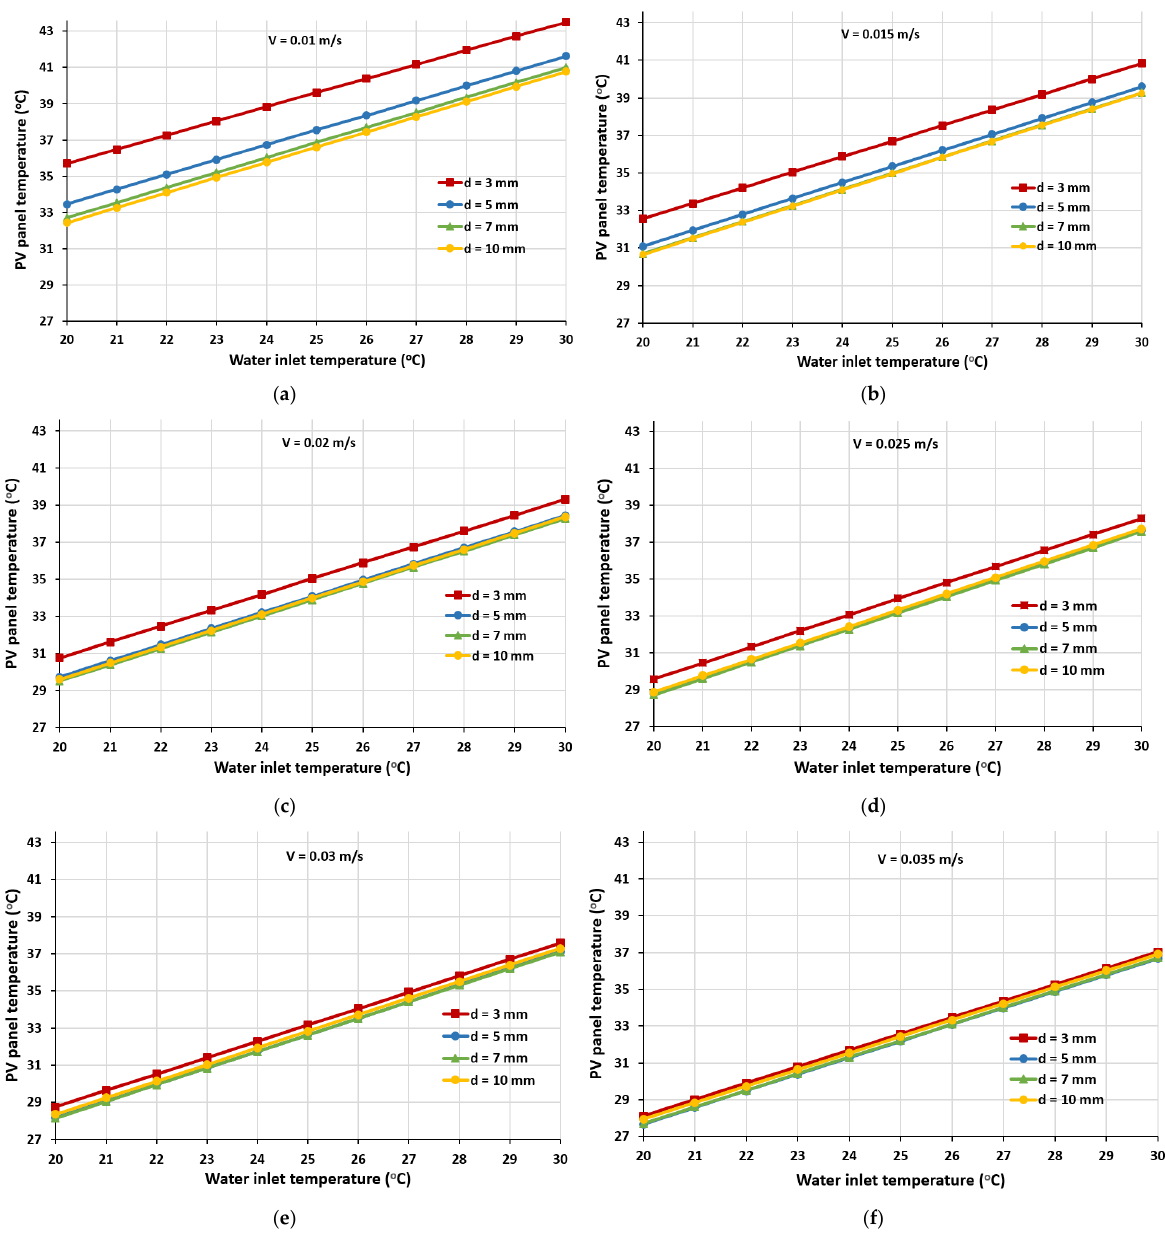
Figure 5. Effect of water thickness on the cooling of the PV cells for different velocities: ( a ) V = 0.01 m/s, ( b ) V = 0.015 m/s, ( c ) V = 0.02 m/s, ( d ) V = 0.025 m/s, ( e ) V = 0.03 m/s, ( f ) V = 0.035 m/s. In Figure 6, the effect of the water film thickness on the fluid heat transfer coefficient and thermal power is illustrated for variable water velocity and inlet temperature. From this figure, it can be seen that with the increase in water thickness, the heat exchange coefficient dropped which decreases the fluid outlet temperature. However, the thermal power increased and reached a maximum value of 1334.5 W at water thickness of 7 mm (water velocity of 0.035 m/s, inlet temperature of 20 °C, and outer temperature of 21.31 °C), Table 4.